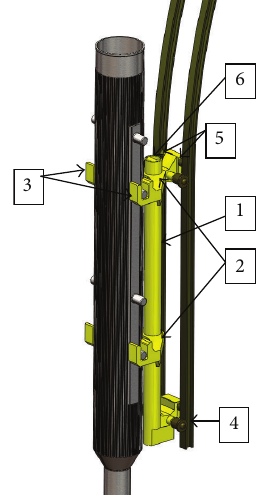
Figure 3: Sodium progressive tilting proposed. Figure4:Intravesselfueltransferpotandramp(1:massivecommon section, 2: gripper cradle, 3: embedded handles, 4: translation wheel, 5: holding counterwheel, and 6: chain